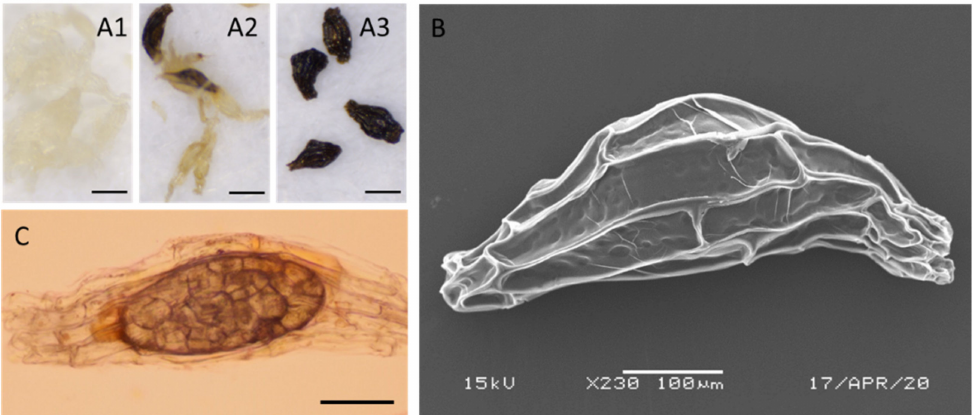
Figure 1. Morphological characterization of P. armeniacum seed and embryo. ( A1 – A3 ) Light microscope images of 73 ( A1 ), 94 ( A2 ), and 150 ( A3 ) DAP seeds. Scale bar = 200 µ m; ( B ) Scanning electron microscopy (SEM) image displays the surface feature of 150 DAP seed. Scale bar = 100 µ m; ( C ) Light microscope image displays the embryo feature of 150 DAP seed, which were treated with 1% sodium hypochlorite to loosen the rigid seed coat structure. Scale Bar = 100 µ m.